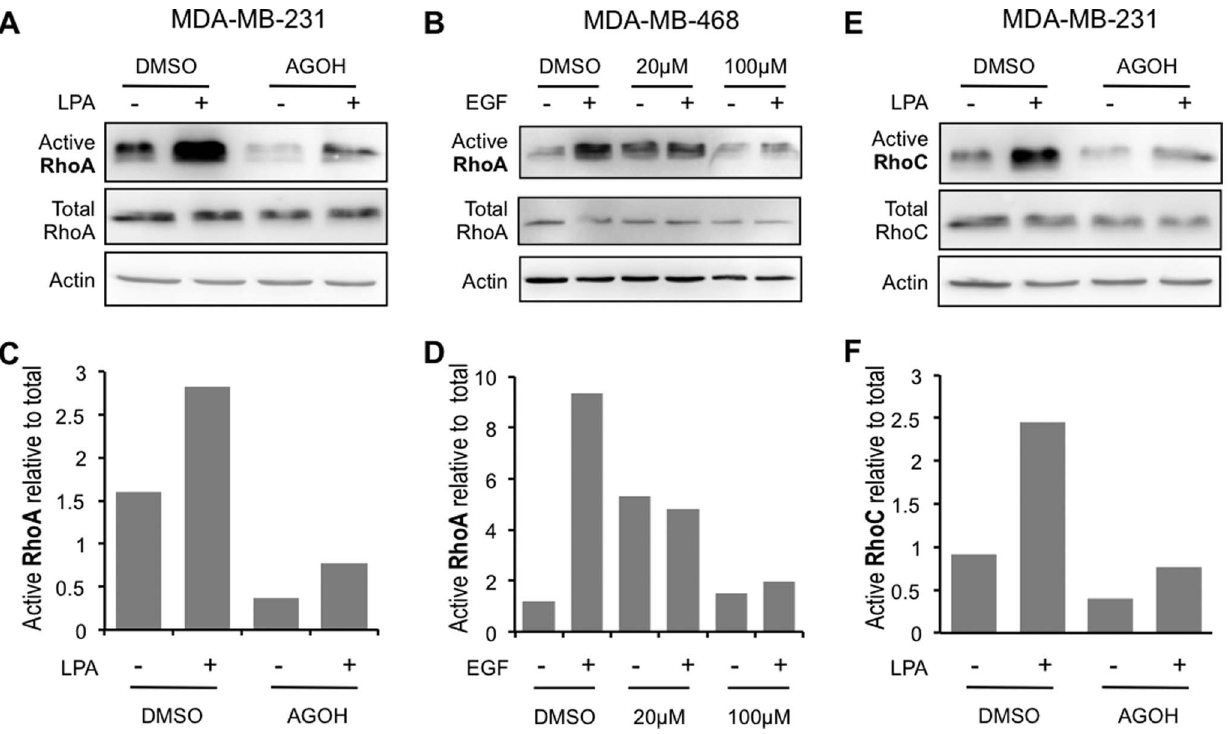
Figure 5. AGOH blocks RhoA and RhoC activation in response to LPA. MDA-MB-231 cells (A and E) or MDA-MB-468 cells (B) were treated with 100 m M AGOH for 3 days, plated on collagen I coated dishes in the presence of PFI and then treated with 100 nM LPA or 5 ng/ml EGF as indicated for 5 min before harvesting for RhoA (A and B, quantified in C and D) or RhoC (E, quantified in F) activity assay. Rho activity assays are representative from at least three separate